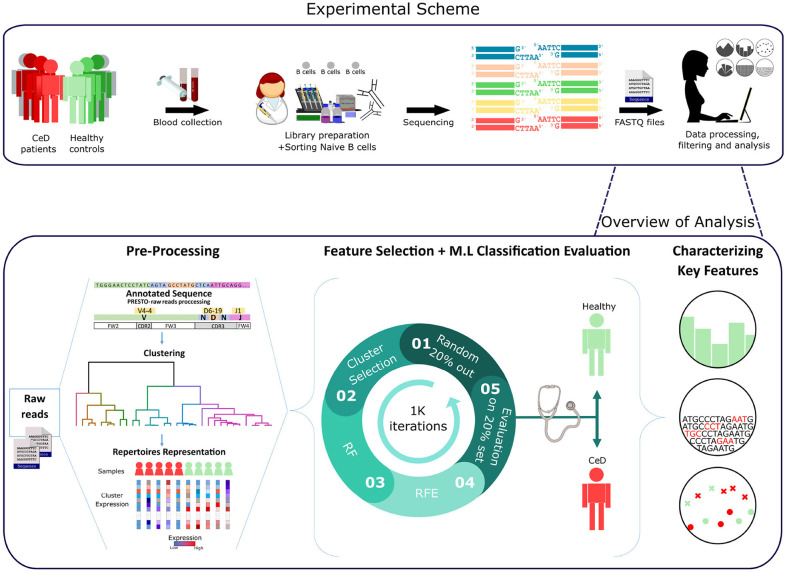
Workflow scheme.Experimental and computational analysis included the following steps: collection of blood samples from individuals with CeD and healthy controls, sequencing of naïve B cell repertoires, and analyzing the repertoires. Repertoire analysis consisted of V(D)J sequence annotation, creation of repertoire representations by antibody clustering, identifying clinical-predictable features using ML methods, and characterizing disease biomarker motifs.